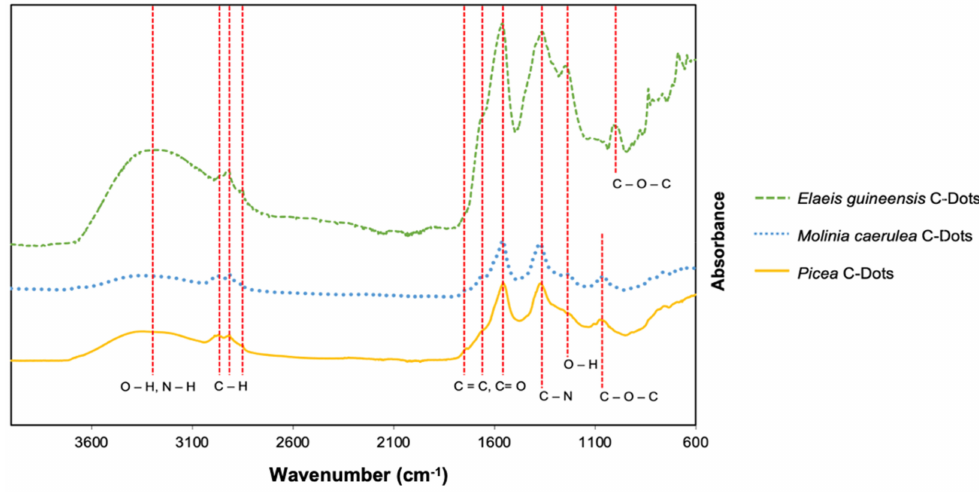
Figure 2. Picea , Molinia caerulea , and Elaeis guineensis C-Dots FTIR